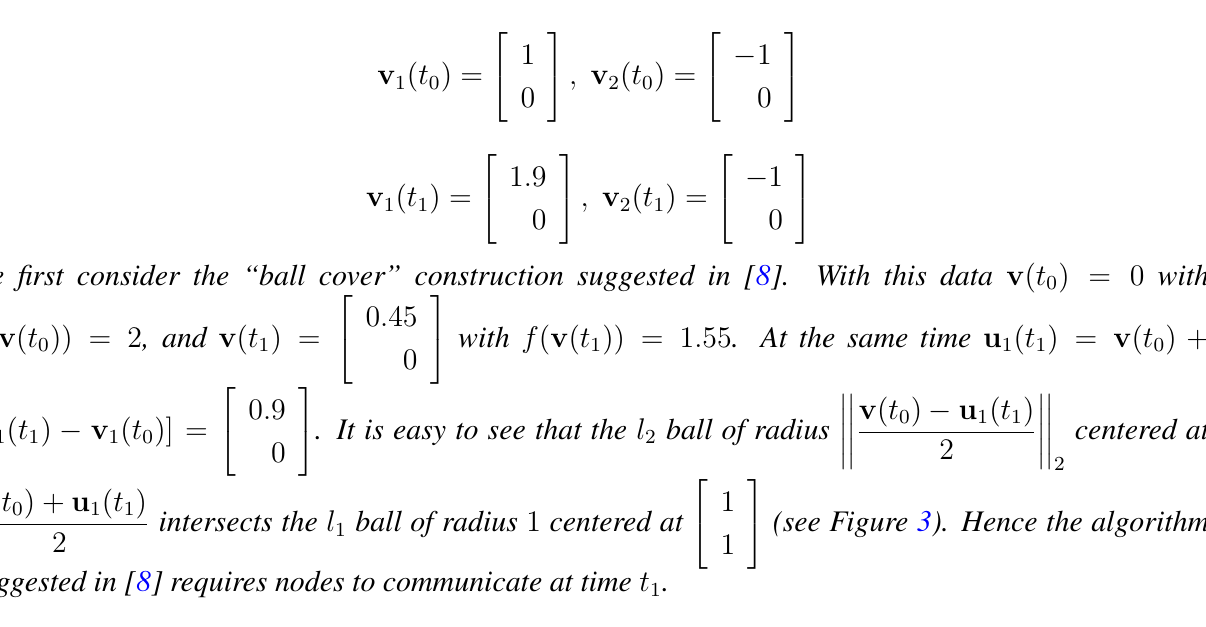
Figure 2. conservative cover by a single l